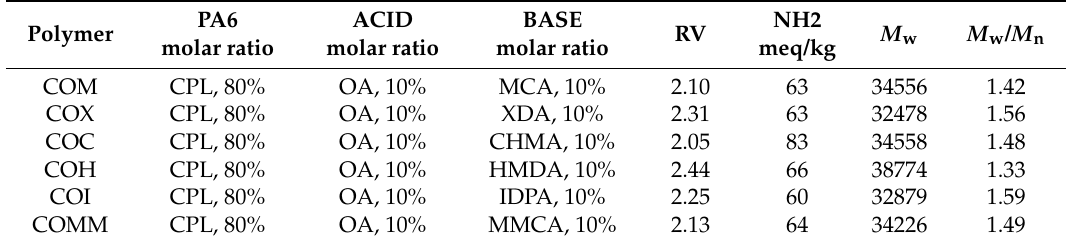
Table 1. Composition of PA6 containing cyclic compounds.